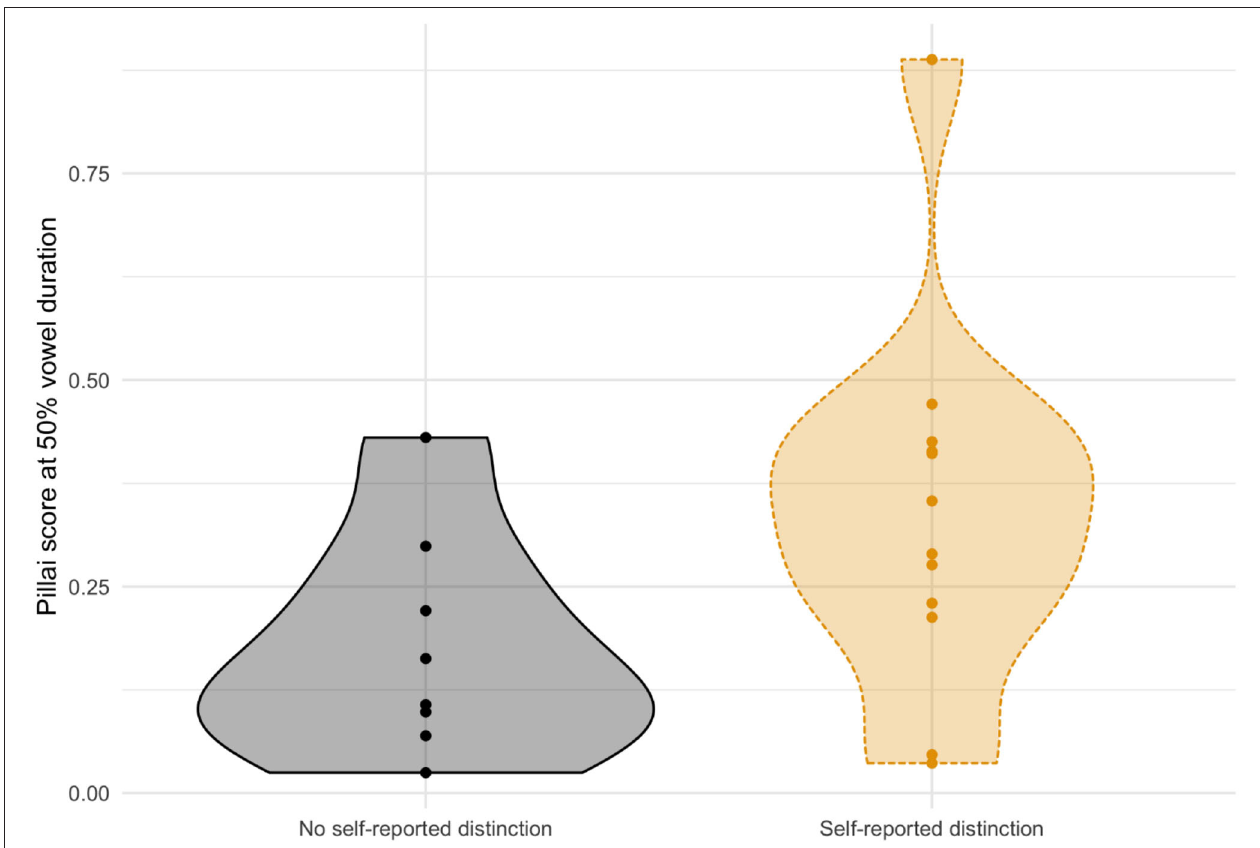
FIGURE 6 | Pillai scores by self-reported contrast for cot-caught. Pillai scores for caught-cot by participant, separated by self-reported distinction of the